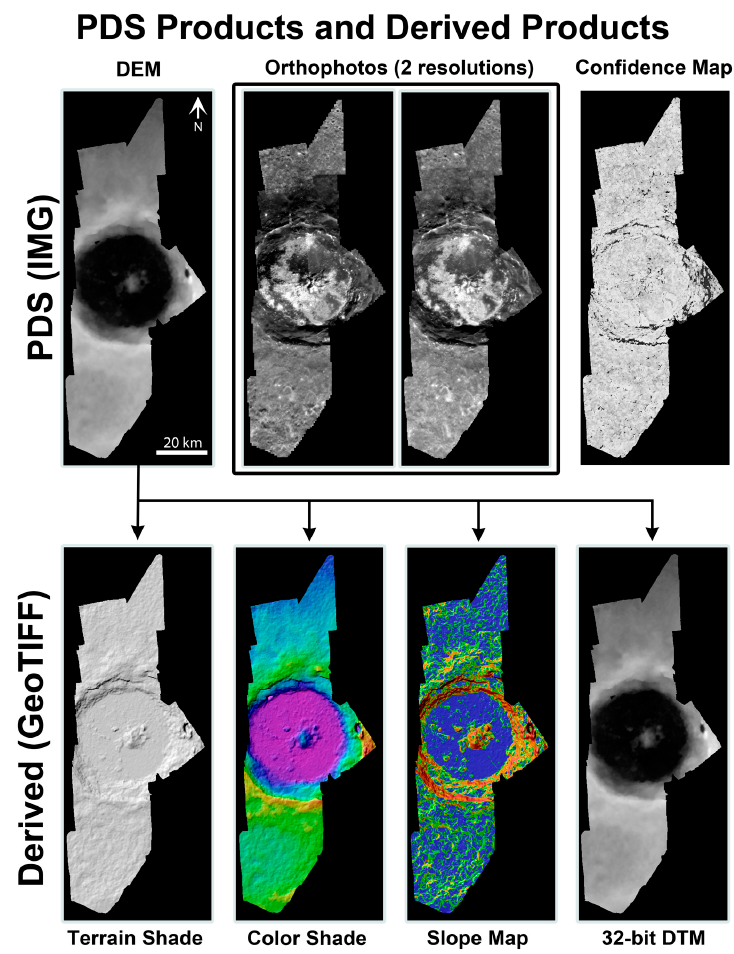
Figure 5. PDS and derived products from the Sander crater DEM mosaic (42.42°N, 154.64°E), created from 21 images forming 36 stereo pairs. The DEM mosaic, orthophoto mosaics at two resolutions, and a confidence map are available in PDS format, as well as individual DEMs, four orthophotos, and confidence maps for each stereo pair. In addition, terrain-shaded relief, color-shaded relief, and slope maps are derived from each DEM and are released as 8-bit GeoTIFFs along with a 32-bit GeoTIFF of the DEM. See Appendix A for stereo pair details.